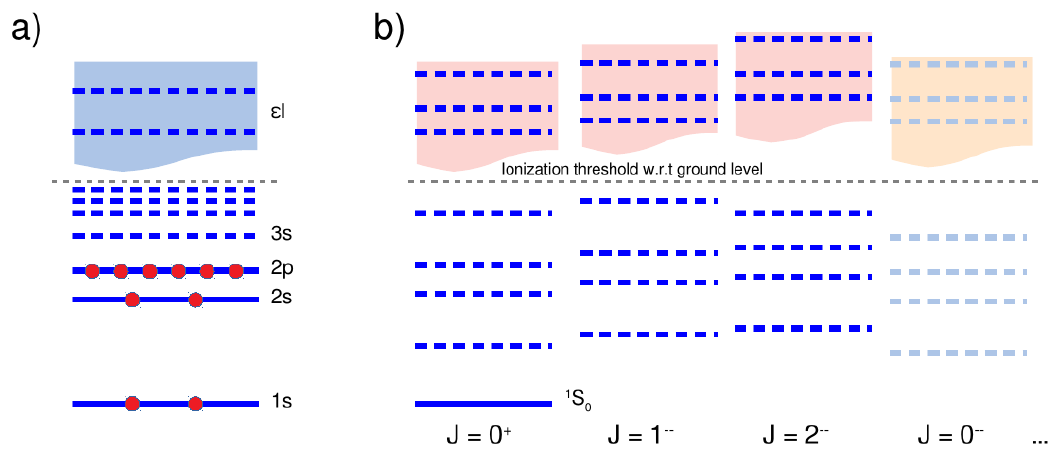
Figure 1. Comparison of the single- and many-electron spectra (continua) of atoms and ions with complex shell structure. In the relativistic theory, the ( a ) single-electron energies (solid and dashed blue lines) follows from the solution of the Dirac equation in a proper central-field potential V ( r ) , and which are designated in the (standard) 1 s , 2 s , 2 p 1/2,3/2 , ... subshell notation, analogue to the hydrogenic atom. Above of the ionization threshold, ε = 0 , there is a single-electron continuum (light blue box) for each symmetry ( κ , m ) , and which is formally often captured by means of a finite summation (integration) over the pseudo-states. ( b ) For many-electron atoms, quite similar, the bound-state solutions (solid and dashed blue lines) are still diagonal in the total symmetry J ≡ J P of the atomic state functions but now requires a proper coupling (and construction) of the CSF; see text for further details. Again, a many-electron continuum (light red boxes) is associated with each symmetry ( J , M ) , although at slightly different threshold energies with regard to the ground-state level. While the subshell occupation (red circles in the left panel) of the many-electron states just refer to the single-electron spectrum, only their total symmetry (and energetic order) are relevant for the classification and distinction of the many-electron continua. The selected occupation and symmetries in both panels refer to neon-like ions with a 1 s 2 2 s 2 2 p 6 1 S 0 ground level. For the 1 s 2 2 s 2 2 p 6 1 S 0 + 2 ¯ h ω → 1 s 2 s 2 2 p 6 3 d 3 D 1,2,3 two-photon absorption of these ions, the dominant E1E1 transition amplitude (1) is based on the J P = 1 − symmetry channel, while the 2 − channel need to be taken into account, in addition, if the E1M2 multipole excitations are considered as well. Other channels (continua) are not relevant for the example from Section